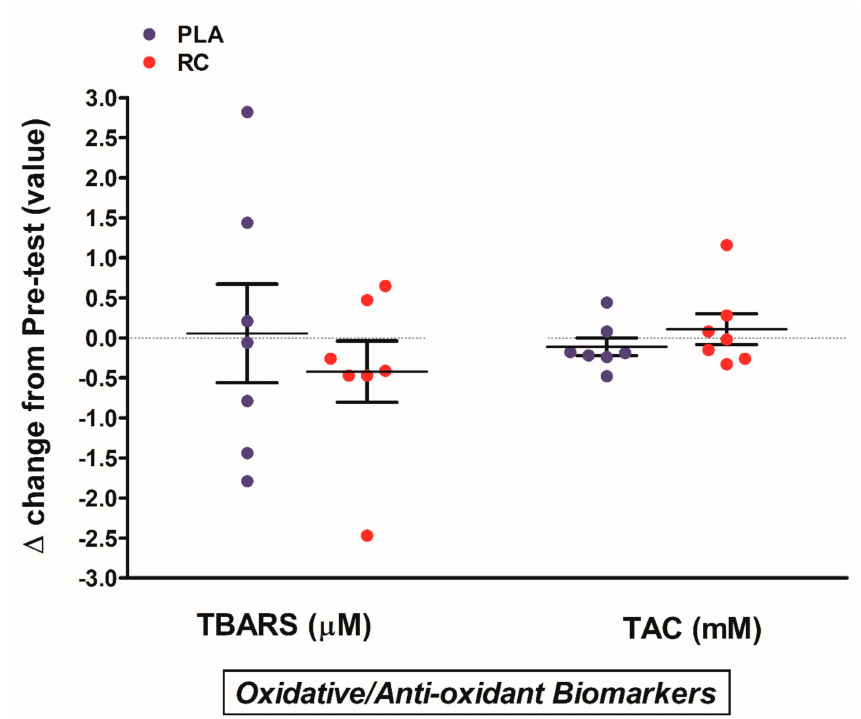
Figure 5. Changes in the oxidative and anti-oxidative biomarkers between the placebo and RC groups after eight-week intervention. No significant di ff erence in TBARS and TAC levels between groups after intervention. Blue solid circle: placebo (PLA); Red solid circle: RC supplementation (RC). TBARS: Thiobarbituric acid reactive substances, TAC: Total antioxidant capacity. Values are expressed as Mean ±